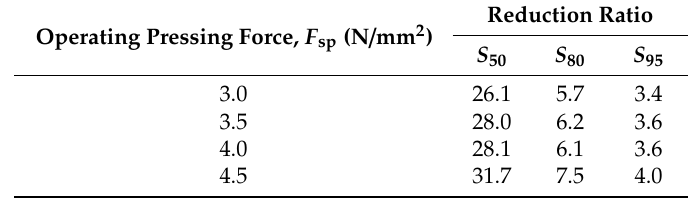
Table 4. Values of 50%, 80% and 95% reduction ratios ( S 50 , S 80 and S 95 ) for high-pressure roller crusher (HRC) crushing products.